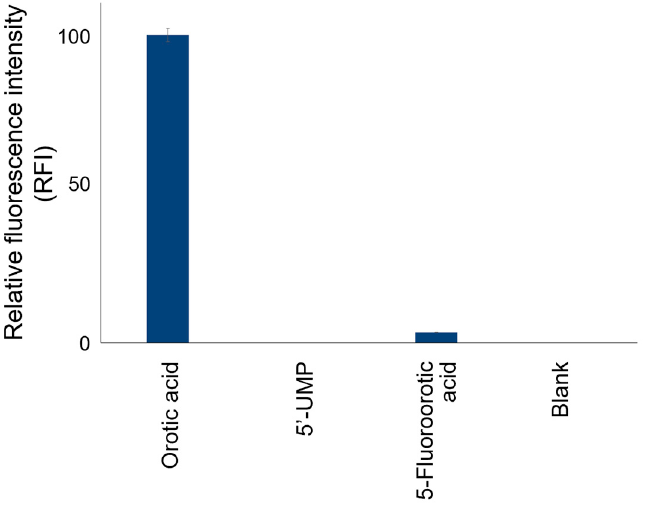
Figure 2. The reaction specificity of the present fluorogenic reaction with 4-TFMBAO to substances associated with OPRT reaction.